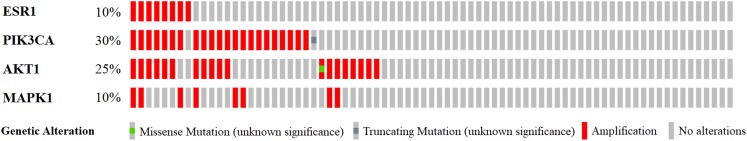
A visual summary of alteration across a set of prostate samples (data taken from the NEPC studies, Nat Med 2016) (Beltran et al., 2016) based on a query of four genes ESR1, PIK3CA, AKT1, and MAPK1.Different genomic alterations are summarized and color coded presented by % changes in particular affected genes in individual tumor samples. Each row represents a gene, and each column represents a tumor sample.